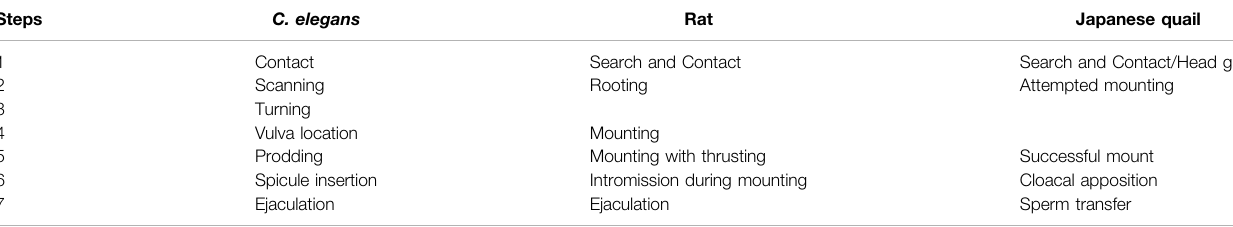
TABLE 1 | | Comparison of male sexual behavior steps in C. elegans , rats, and Japanese quail.